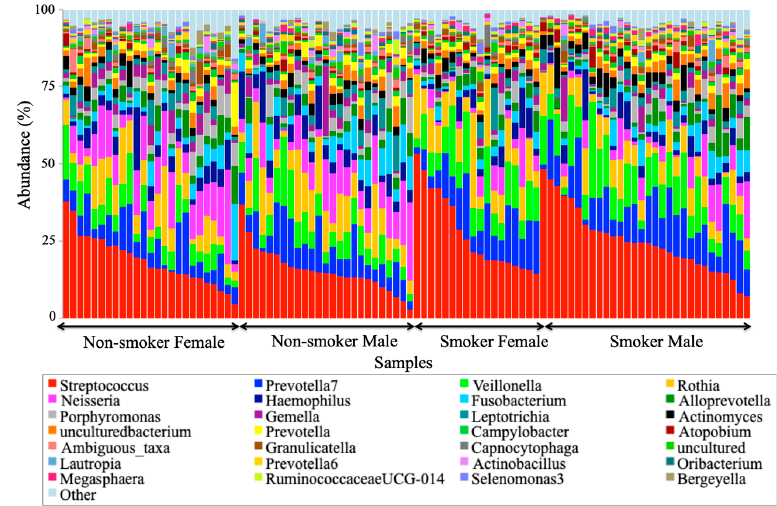
Figure 5. The relative abundance of genera per sample group per smoking status and gender.